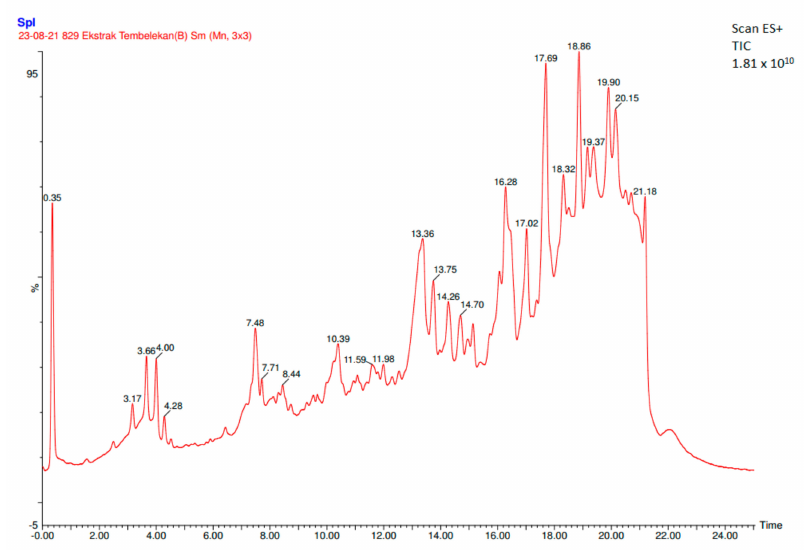
Figure 2. Chromatogram of chemical constituents from fraction B of Patiwala